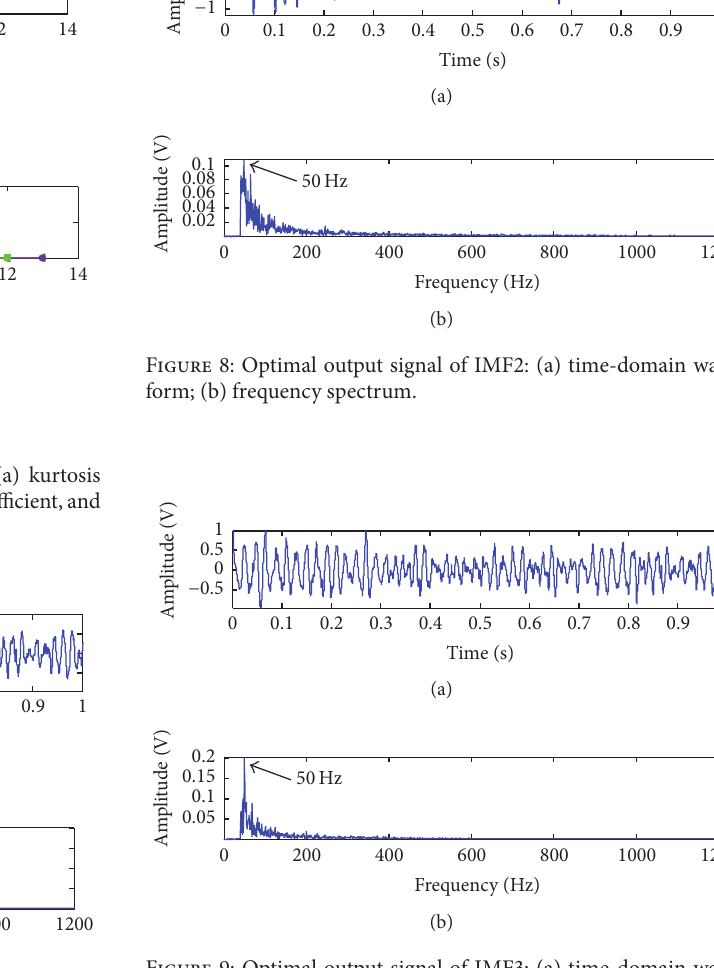
Figure 9: Optimal output signal of IMF3: (a) time-domain wave- form; (b) frequency spectrum.